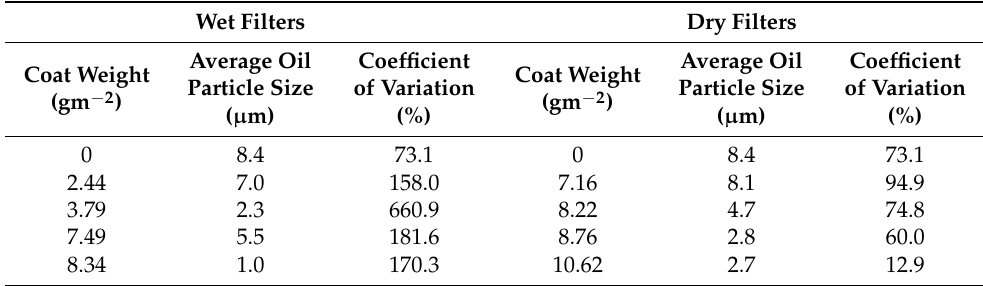
Figure 4. Photographs and microscopy imaging of oil-water emulsions before (i) and after (ii) filtration through an ( a ) unmodified control filter, ( b ) wet 2.44 gm − 2 filter, ( c ) wet 8.34 gm − 2 filter, and ( d ) dry 8.22 gm − 2 filter. Table 1. The average size of oil particles in filtrates after running an oil-water emulsion through wet and dry filters at various LNCF coat